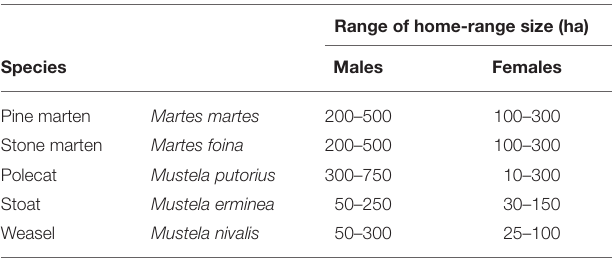
TABLE 1 | Typical home-range (H-R) sizes of mustelids in Denmark based on European studies (see Supplementary Table